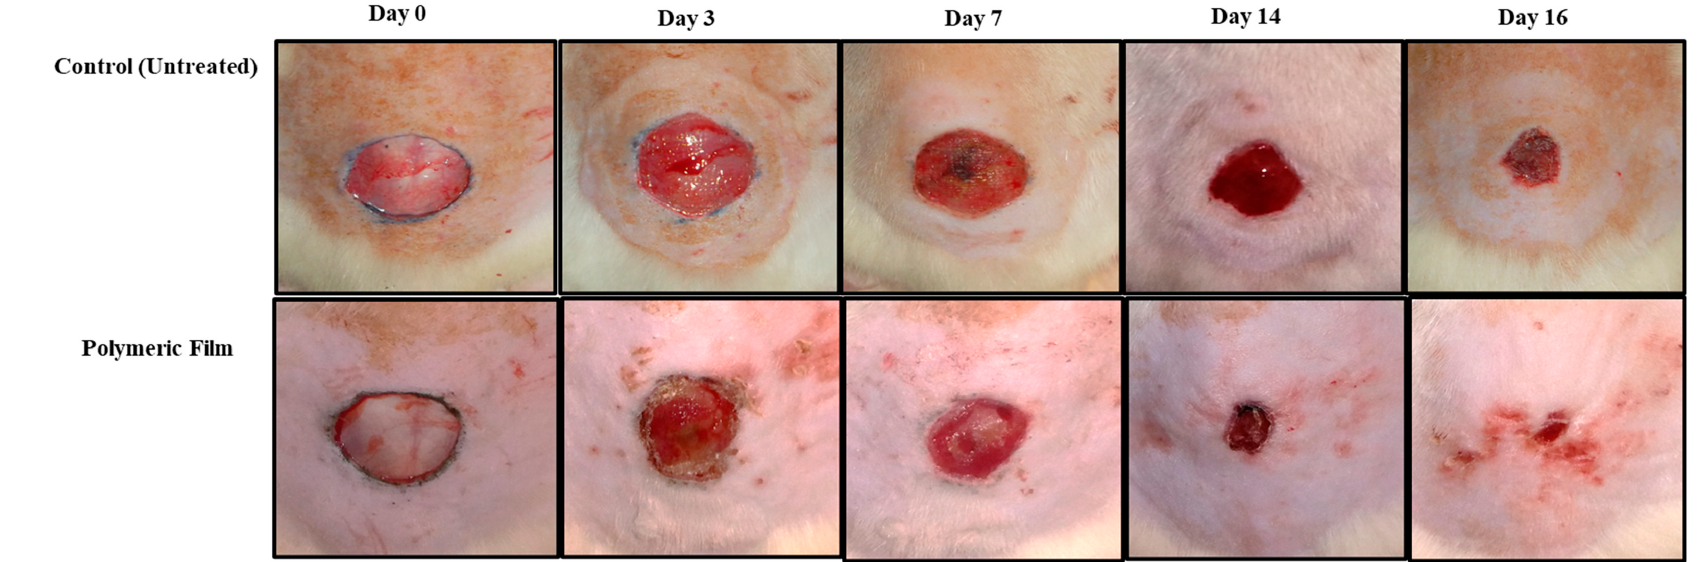
Figure 7. Photographs of skin wound morphology with and without film treatment in diabetic rats.